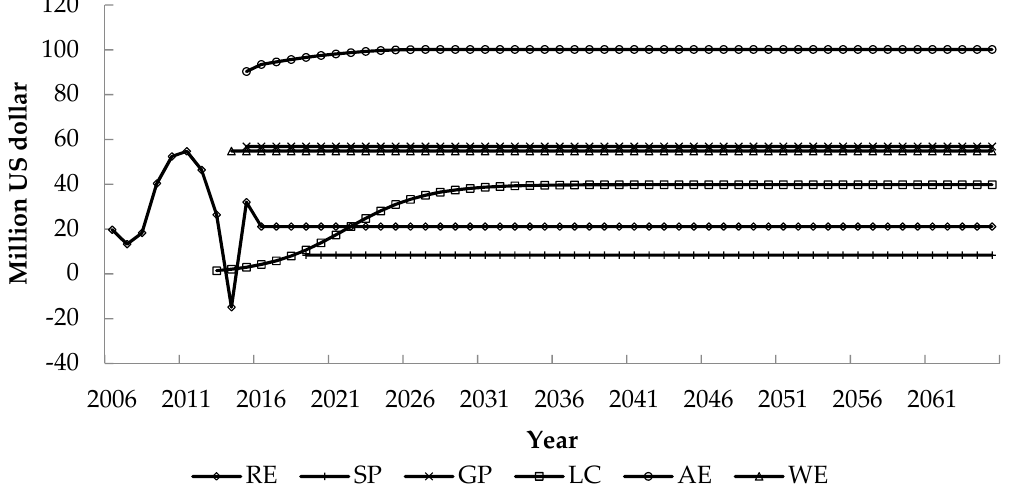
Figure 1. External benefits brought by the Z hydropower development.